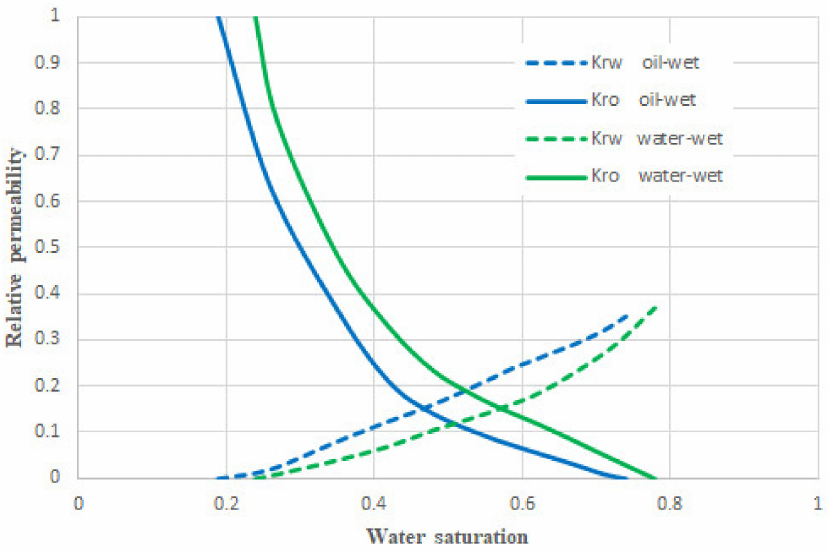
Figure 3. Relative permeability (green and blue lines are for oil-wet and water-wet